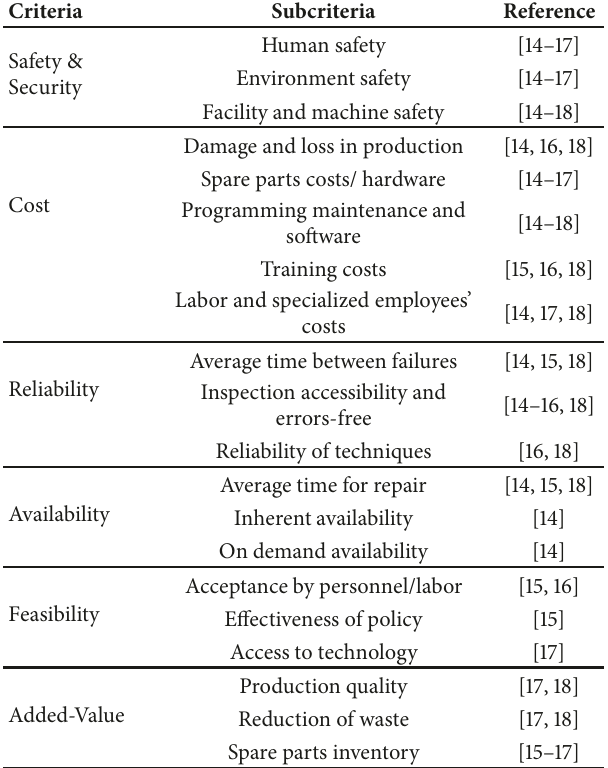
Table 2: Criteria and subcriteria for selection of maintenance strategy using fuzzy-MCDM hybrid methodology.